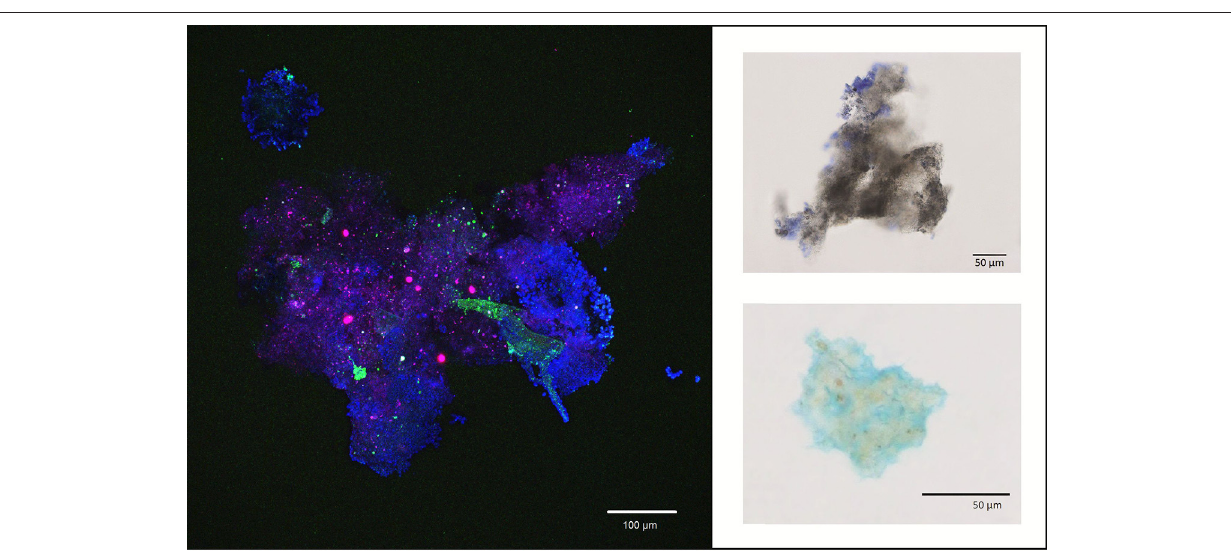
FIGURE 4 | Left: Exemplary confocal laser scanning micrograph, showing an aggregate collected with the Marine Snow Catcher. Blue, polysaccharide-containing structures; green, structures containing nucleic acids; red, structures containing chlorophyll. Right: Aggregates (or aggregate fragments) from the Marine Snow Catcher stained with Coomassie Brilliant Blue G (staining of CSP material; upper right) or Alcian Blue (staining of TEP material; lower